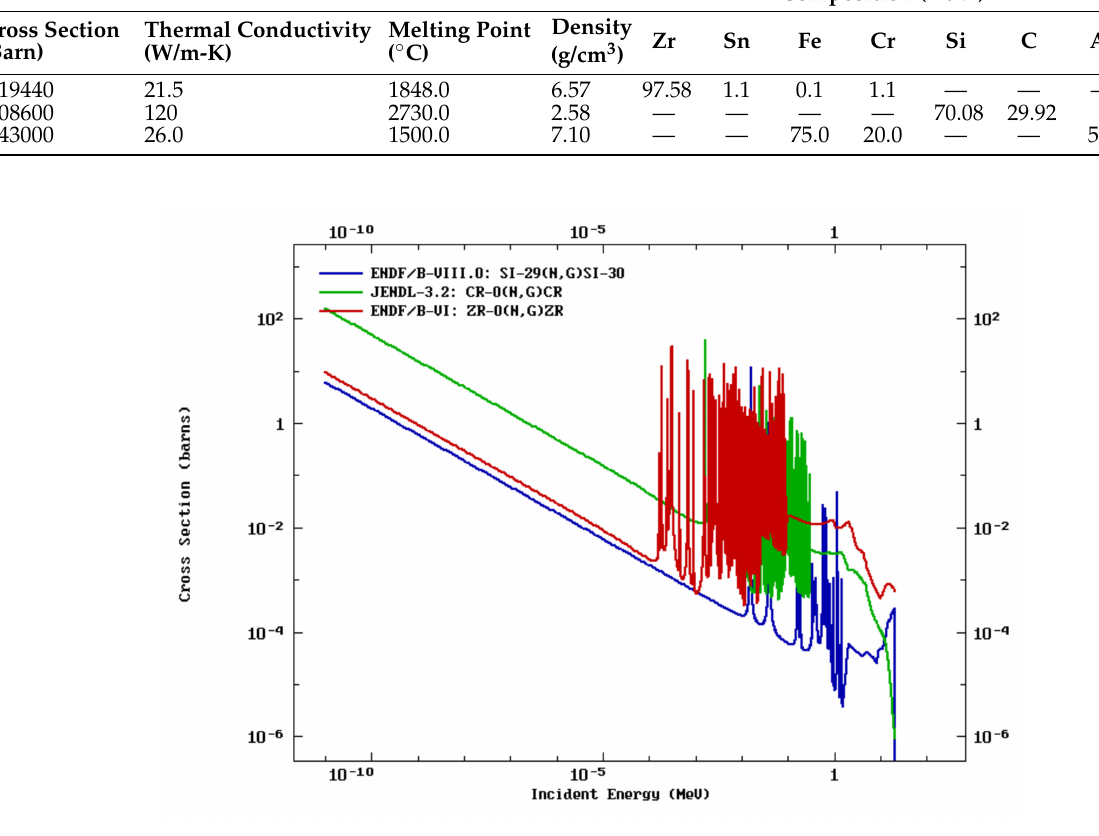
Figure 2. Microscopic absorption cross-section of the Zr, Si, and Cr.